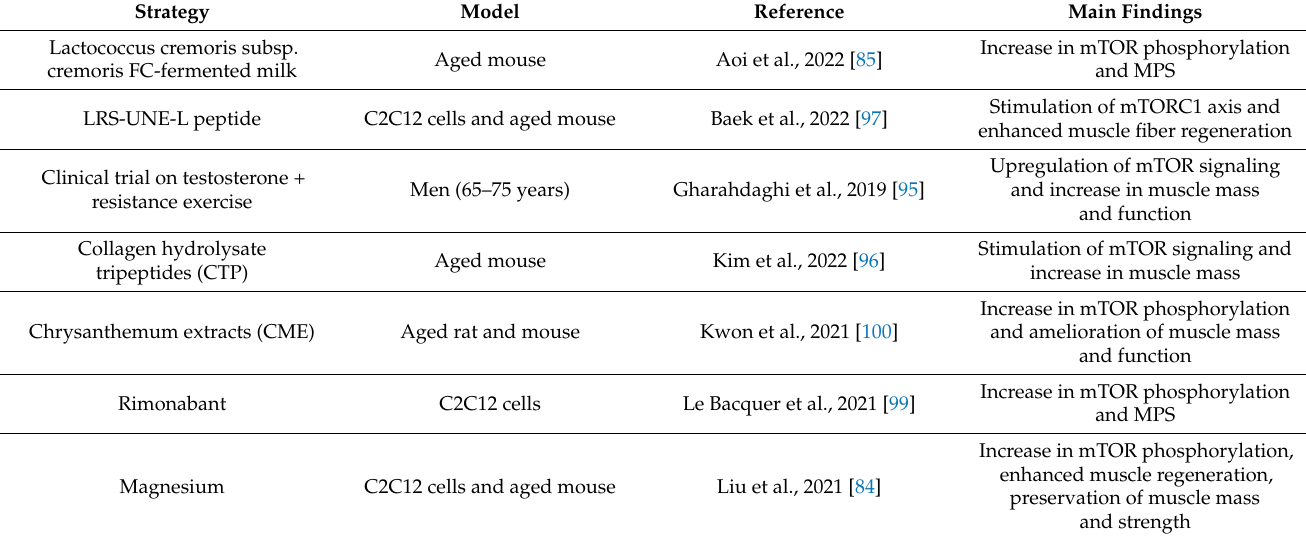
Table 1. Strategies and ongoing preclinical studies targeting the mTOR